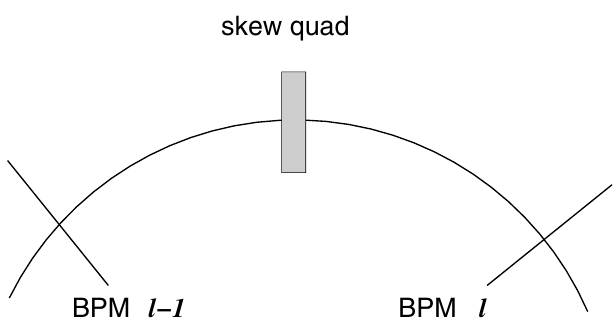
FIG. 7. Schematic view of a skew quad and the neighbor